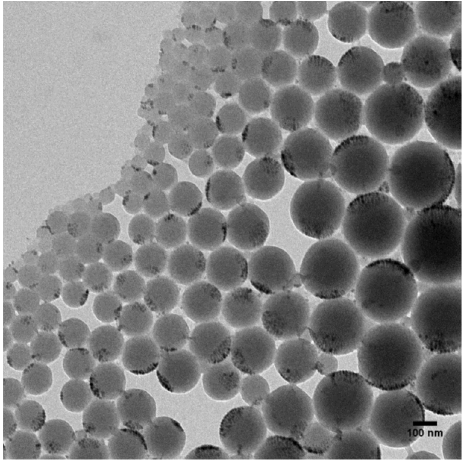
Figure 7. Transmission Electron Measurements (TEM) image of PS nanoparticles with encapsulated SPIONs.